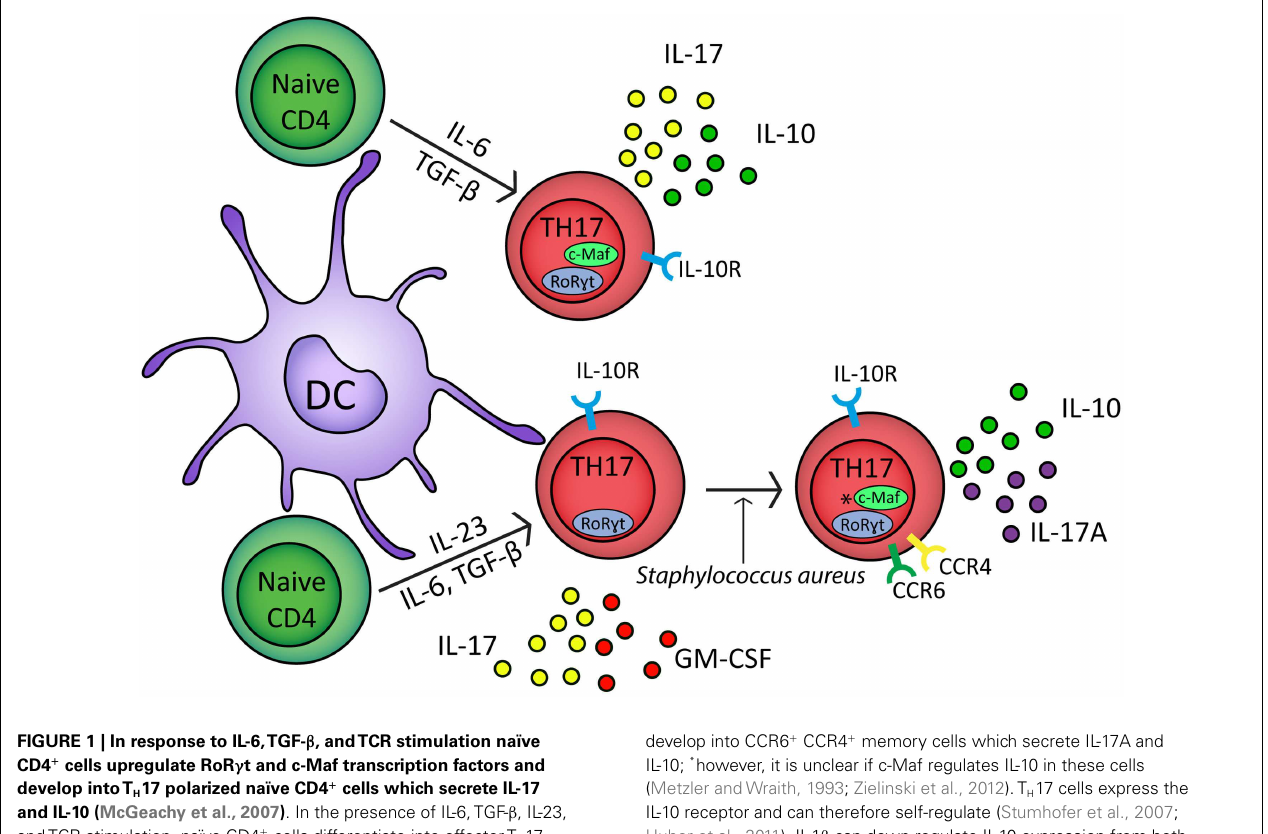
FIGURE 1 | In response to IL-6,TGF- β , andTCR stimulation naïve CD4 + cells upregulate RoR γ t and c-Maf transcription factors and develop intoT H 17 polarized naïve CD4 + cells which secrete IL-17 and IL-10 (McGeachy et al., 2007) . In the presence of IL-6,TGF- β , IL-23, andTCR stimulation, naïve CD4 + cells differentiate into effectorT H 17 cells which express RoR γ t and secrete IL-17 and GM-CSF (McGeachy et al., 2009). In response to Staphylococcus aureus , effectorT H 17 cells